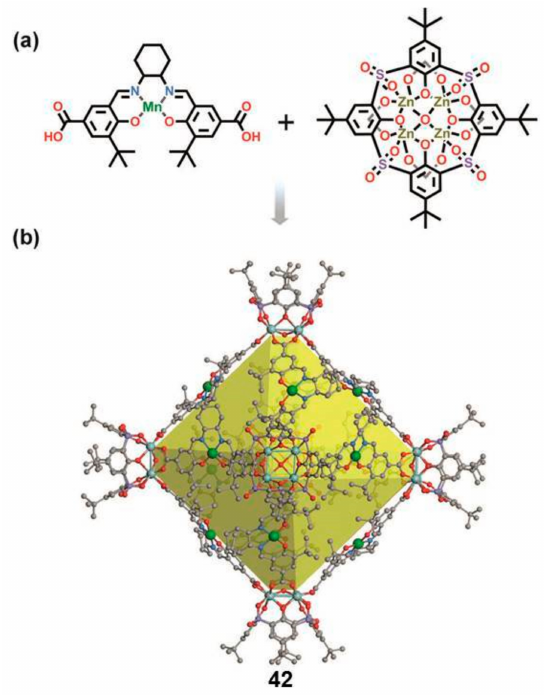
Figure 7. ( a ) Structures of the building blocks of nanocage 42 ; ( b ) single-crystal X-ray structure of the nanocage 42 . The cavity is highlighted by a yellow polyhedron (reproduced from Ref. [39], with permission of John Wiley and